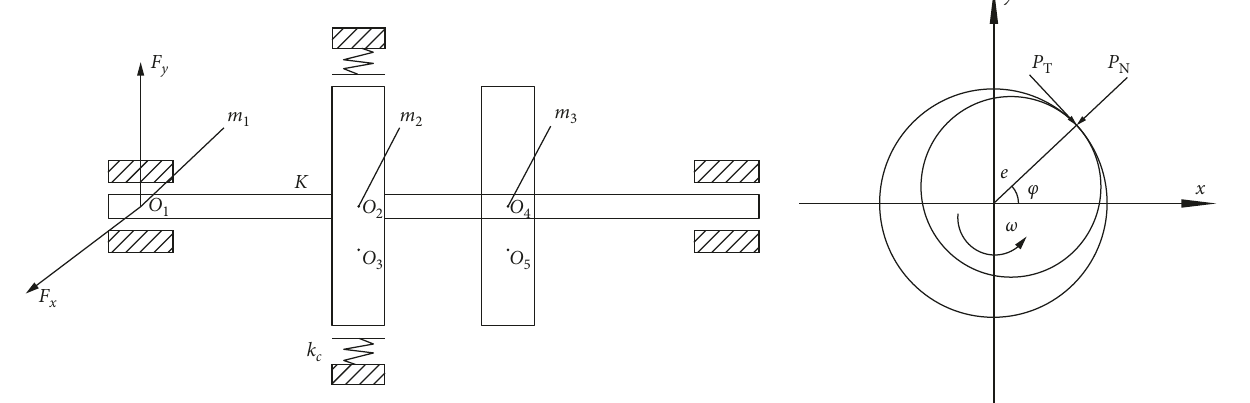
Figure 1: (a) Mechanical model of the rotor system. (b) Model of rub